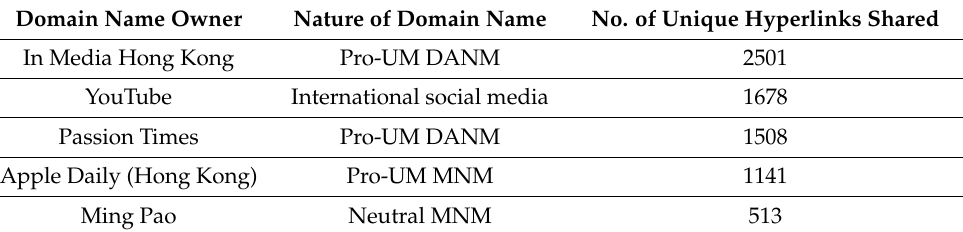
Table 5. Top five domains in external content shared on public Facebook pages/groups during